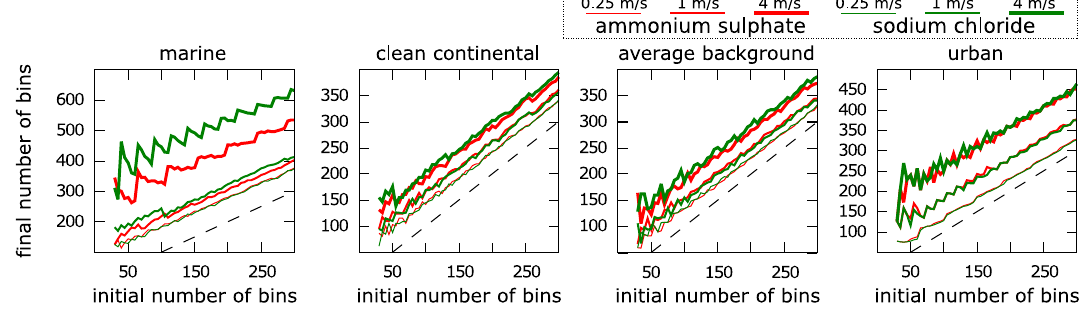
Fig. 6. Final number of bins plotted as a function of the initial number of bins for the model runs with adaptivity presented in Fig. 5 and discussed in Sect. 3.3. Dashed lines in the plot are 1 : 1 lines representing cases without adaptivity. Consult the caption of Fig. 4 for explanation of the plot elements.